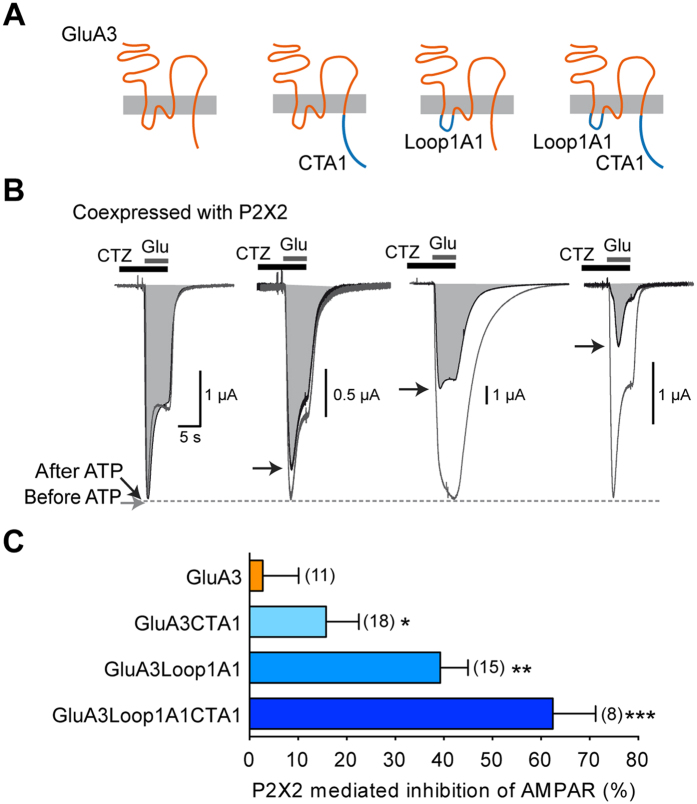
Chimeric GluA3 subunits with intracellular loop1 and CT of GluA1 confers P2X2-mediated inhibition on GluA3 receptors.(A) Schematic representation of chimeric GluA3 subunits bearing the first intracellular loop and/or the CT of GluA1. (B) Surimposed glutamate-evoked currents before and after ATP-induced P2X2R currents recorded from oocytes co-expressing P2X2R and the corresponding modified GluA3 subunits. Maximal amplitude of AMPAR currents after ATP (shaded areas) are indicated by black arrows. (C) Bar graph showing the percentage of P2X2-mediated AMPAR current inhibition for wild-type GluA3 and chimeric GluA3 receptors. Statistical differences compared to GluA3 are indicated. *p < 0.05; ***p < 0.001; Numbers of cells are indicated in parentheses.